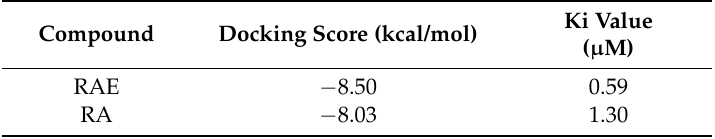
Table 1. Docking score and Ki value results of RAE and RA for Akt kinase.